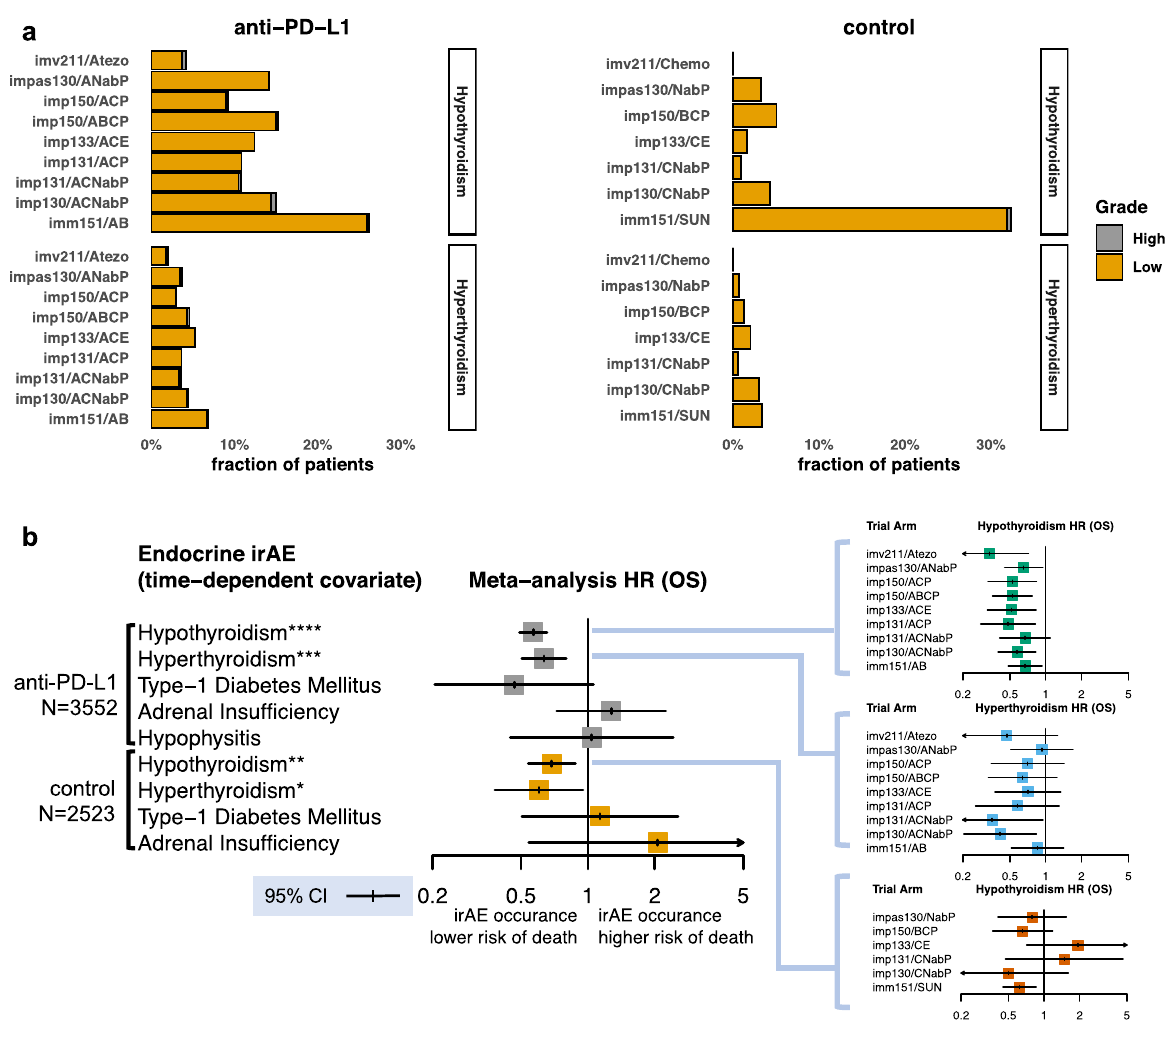
Fig. 1 Thyroid irAE are common and associated with longer overall survival during treatment with atezolizumab as monotherapy or in combination. a Fraction of patients that developed hypothyroidism and hyperthyroidism irAE across atezolizumab trials and their corresponding control arms. Low designates Common Terminology Criteria for Adverse Events (CTCAE) grading of 1 and 2. High designates CTCAE grade >2. b Left, results of an individual participant data (IPD) meta-analysis showing the 95% con fi dence intervals (CI) and point estimate for a time-dependent covariate in a Cox model associating occurrence of a given endocrine irAE and overall survival in patients treated with atezolizumab ( N = 3552) or with standard of care